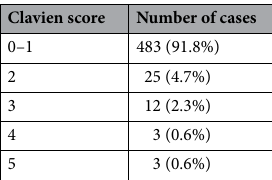
Table 4. Distribution of complications among patients, according to the Clavien-Dindo classification.